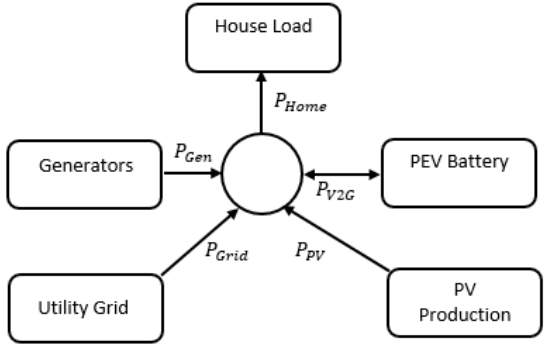
Figure 6. Power distribution with PEV and PV connected.